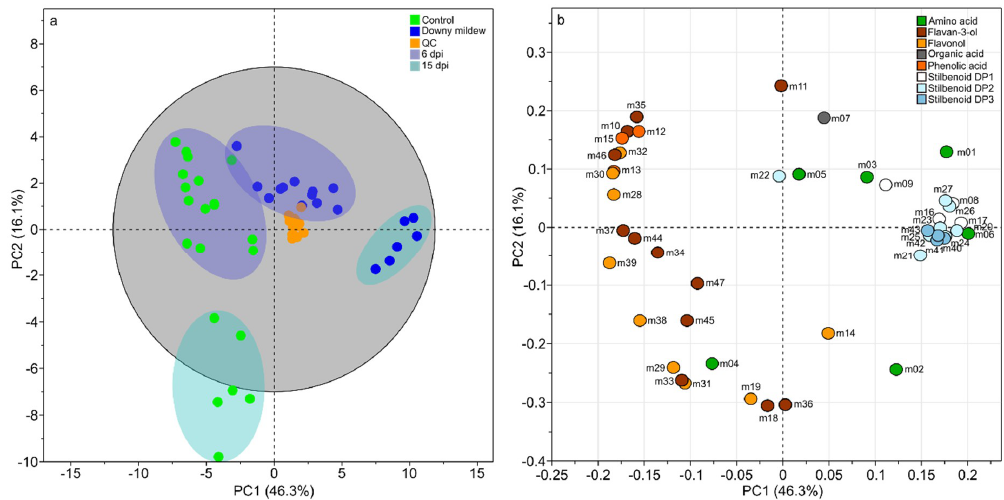
Figure 1. Unsupervised classification using principal component analysis (PCA) on the relative concentration of 47 metabolites from leaves of Vitis vinifera L. cv. Malbec upon downy mildew infection. Score plot ( a ). Dark blue ellipses: 6 days post infection (dpi). Light-blue ellipses: 15 dpi. Loading plot ( b ). Numbers indicate the ID of the compounds as given in Table 1.